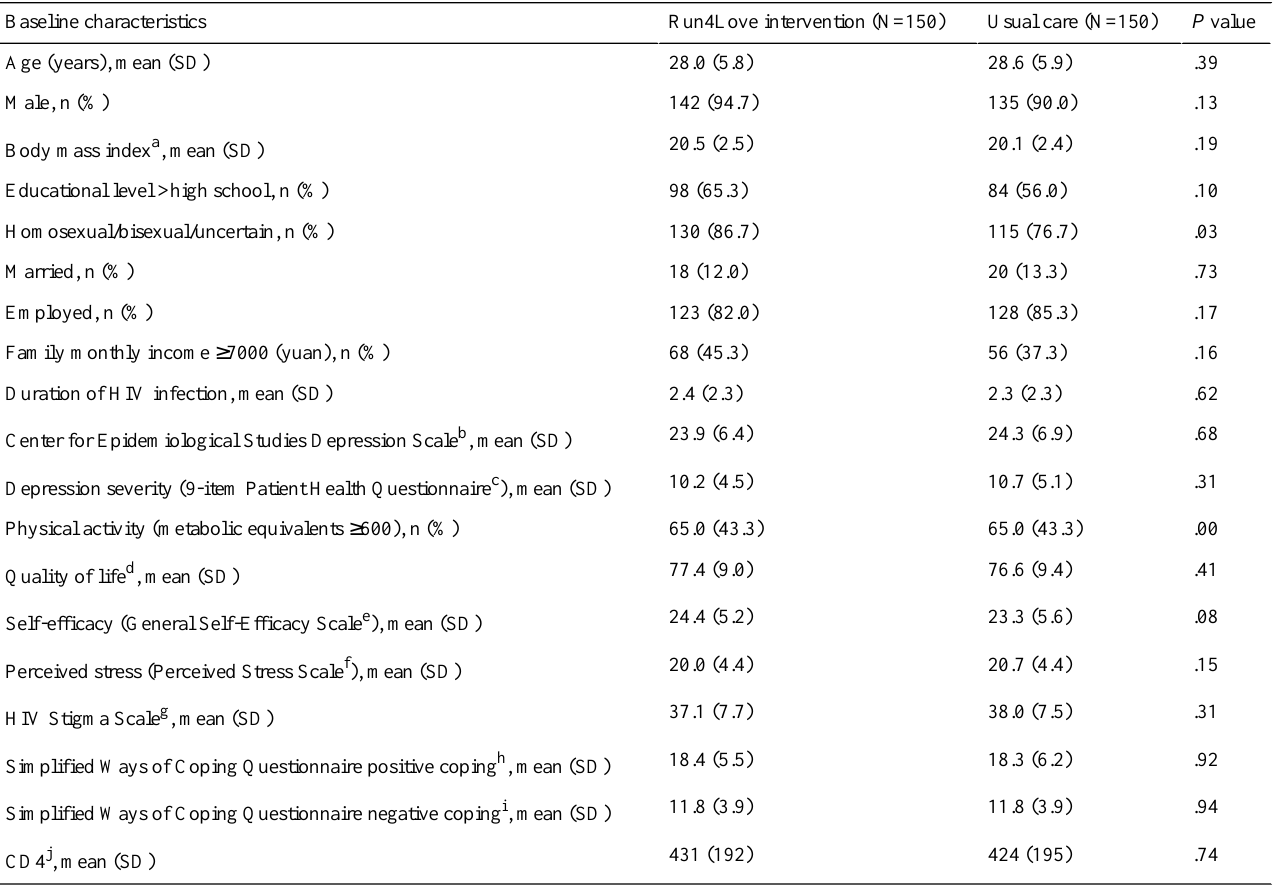
Table 1. Baseline characteristics of participants in the intervention and control